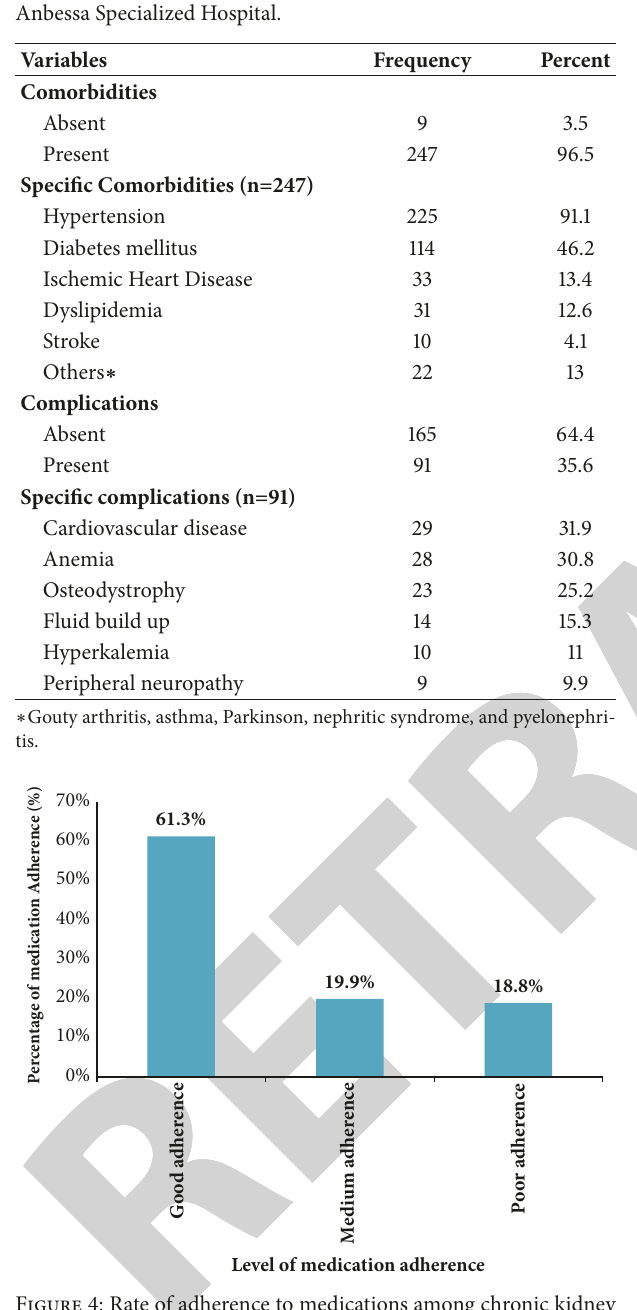
CKD. ACEIs/ARBs increase potassium and decrease